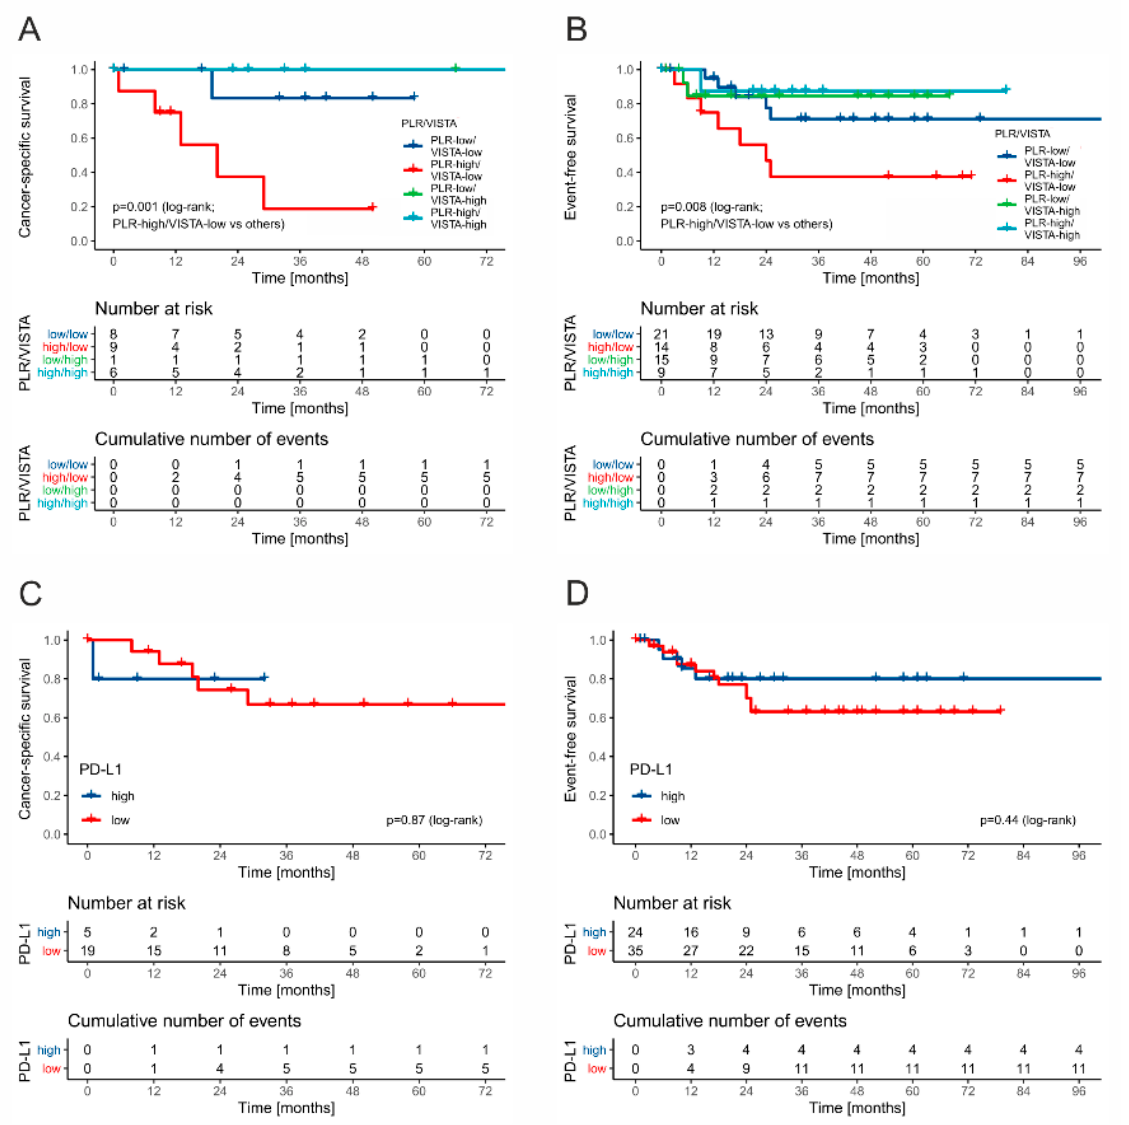
Figure 8. The Kaplan–Meier curves for event-free survival and cancer-specific survival in stage II/III patients stratified by VISTA and PLR (( A ) and ( B ), respectively) and PD-L1 (( C ) and ( D ), re- spectively).